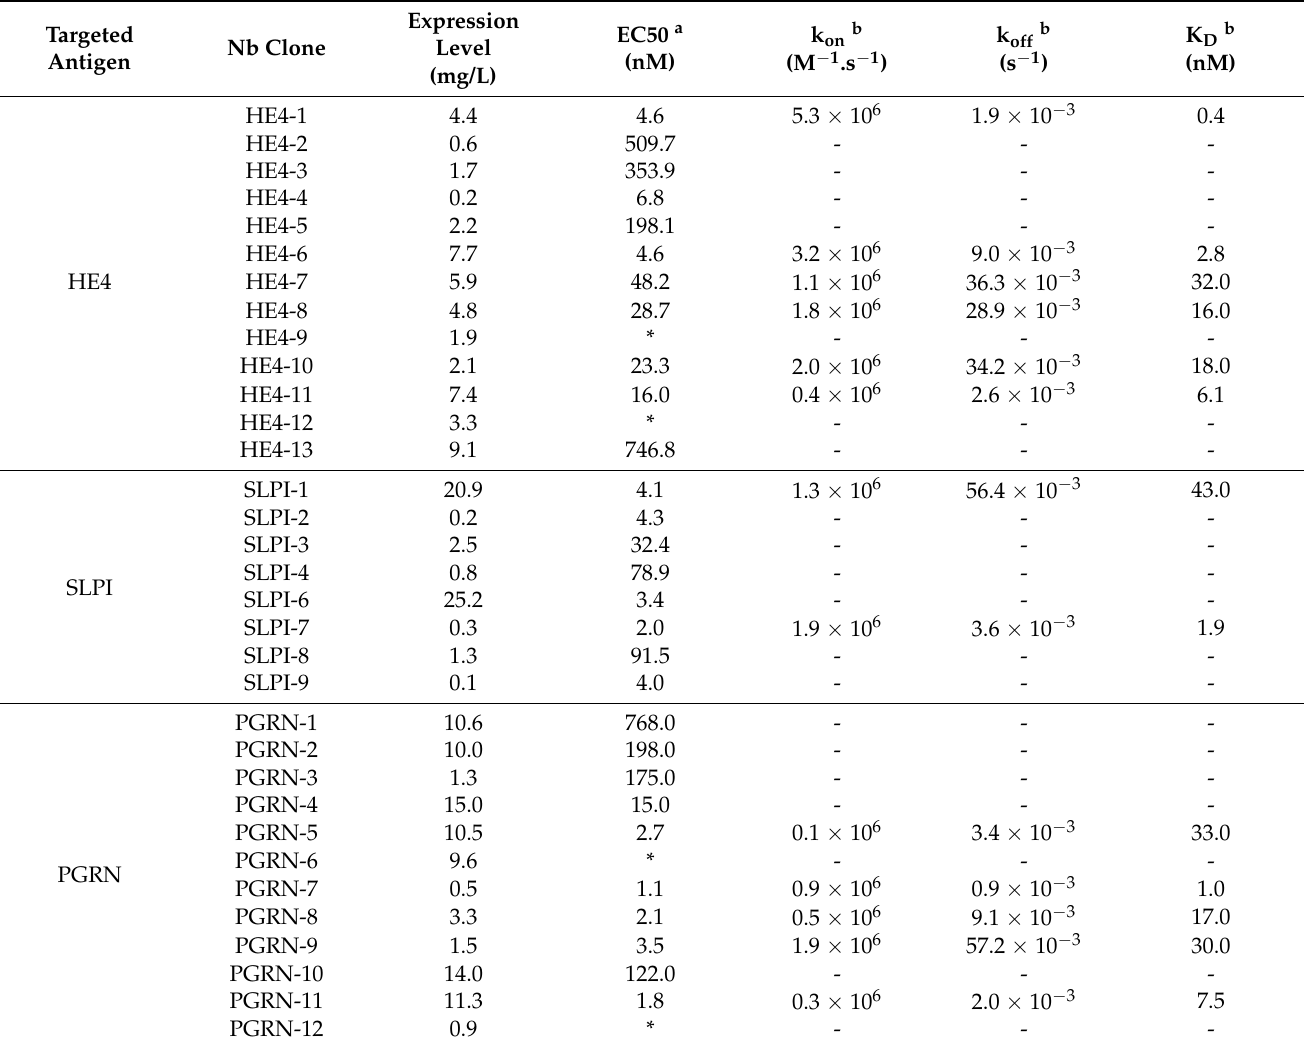
Table 1. Expression levels of the nanobodies targeting HE4, SLPI, and PGRN and equilibrium dissociation constants (K D ), as measured by indirect ELISA and expressed by the EC50 value. Clones expressed at levels >25 mg/L and showing a K D < 50 nM were further studied using SPR to assess their binding